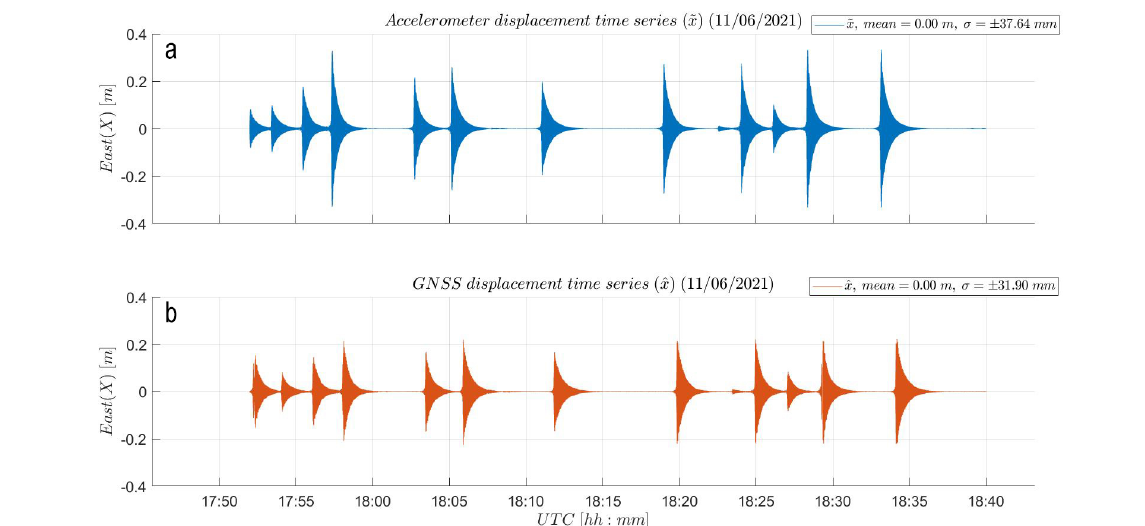
Figure A7. AID experiment results: ( a ) Accelerometer and ( b ) GNSS (bottom) dynamic displacement time series. Good match in amplitude between the displacement time series. Slightly larger amplitudes are visible in panel ( a ) for the high-rate (50 Hz) accelerometer. The smartphone accelerometer displacement time series is affected by a constant clock drift, making it run ahead of the (more accurate) GNSS receiver clock. The identified smartphone clock stability is of 0.01 s